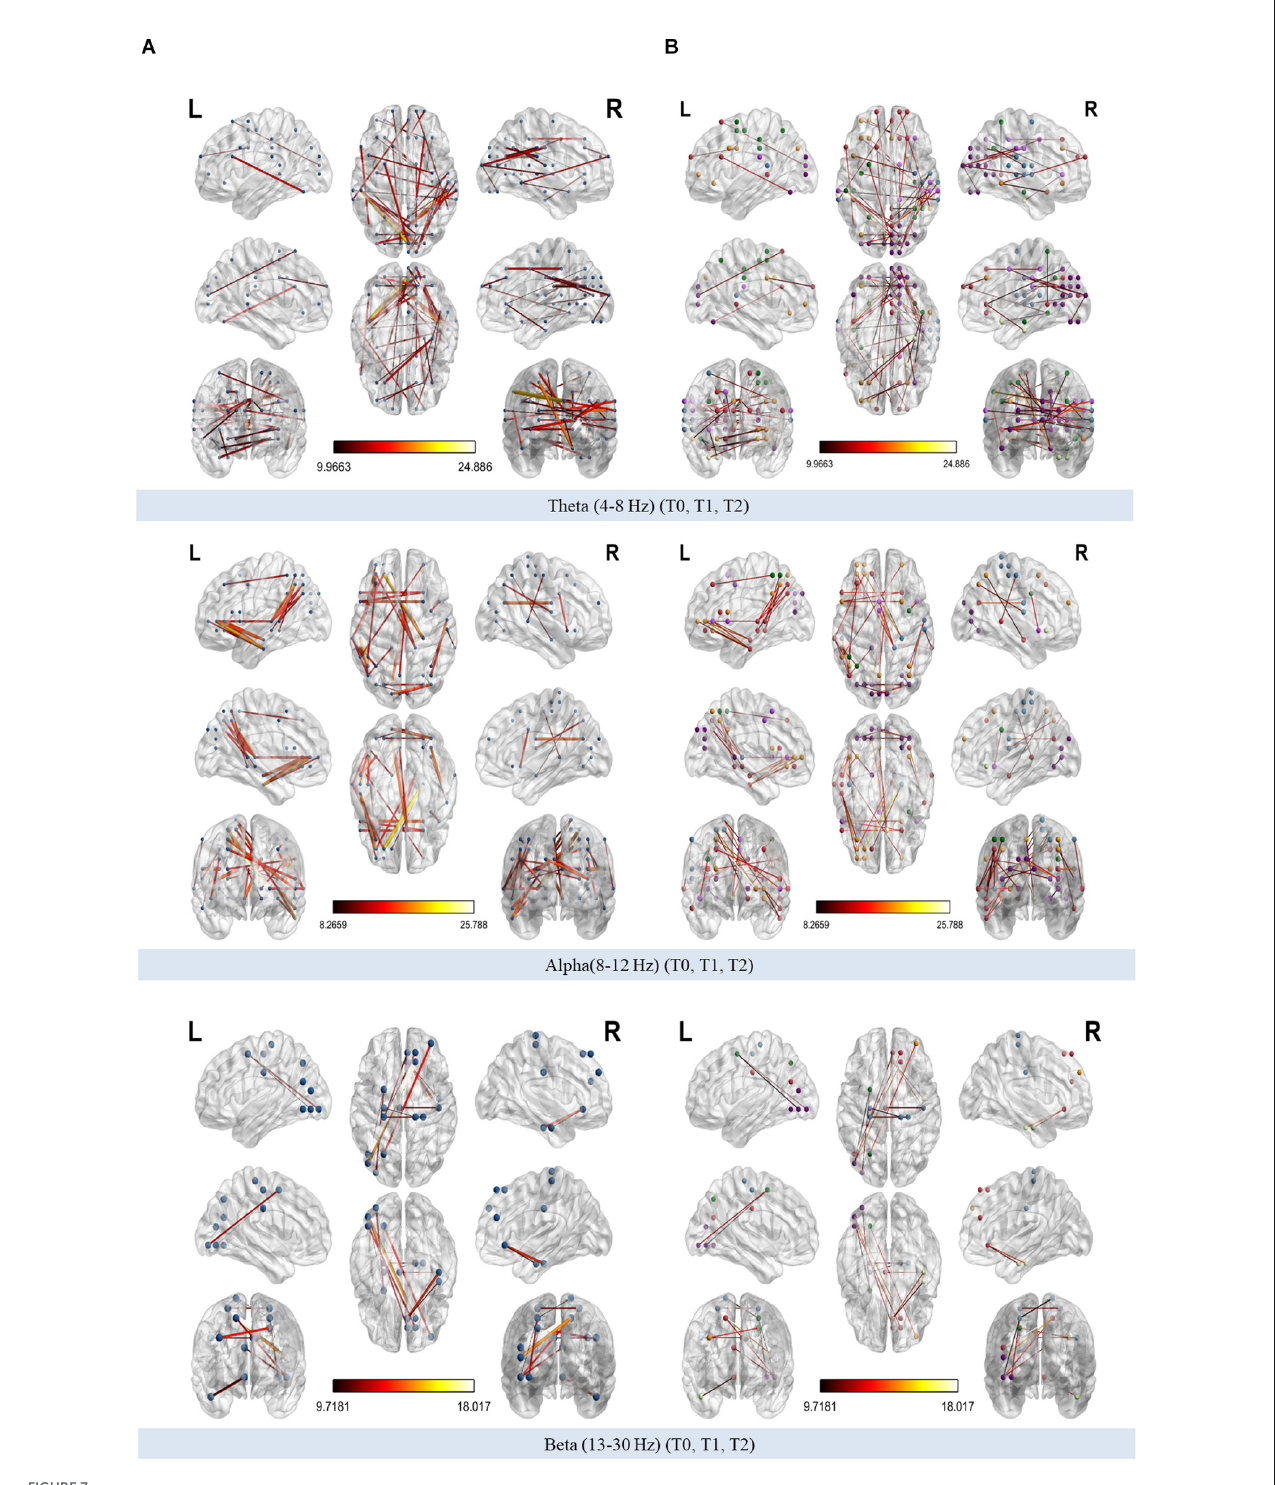
FIGURE7 (A) Modified connections of phase-lag index (PLI) networks (theta, alpha, and beta bands respectively) across time. (B) Modified connections of theta, alpha, and beta PLI networks across time annotated according to 7-network estimate described by Thomas Yeo et al. (2011).